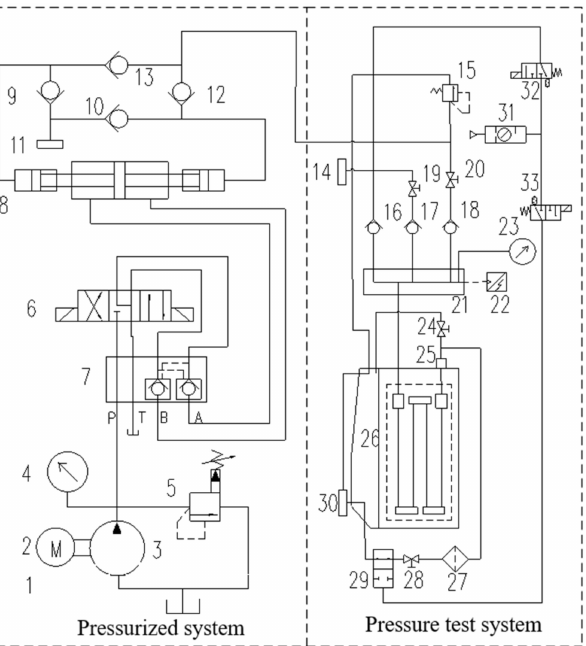
Figure 14. Booster circuit diagram. 1—tank; 2—motor; 3—vane pump; 4 and 23—pressure gauge;